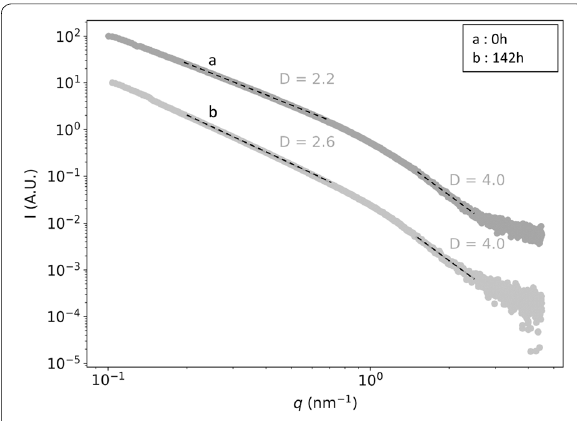
Fig. 5 Small-angle X-ray scattering data shown as a double-logarithmic q – I plot for nanofibrillated cellulose samples 0 and 142 h after cellulase hydrolysis started. a Before saccharification. b After saccharification for 142 h. Circles are measured data. Straight lines were fitted to the results using the power law I ( q ) the D values obtained are